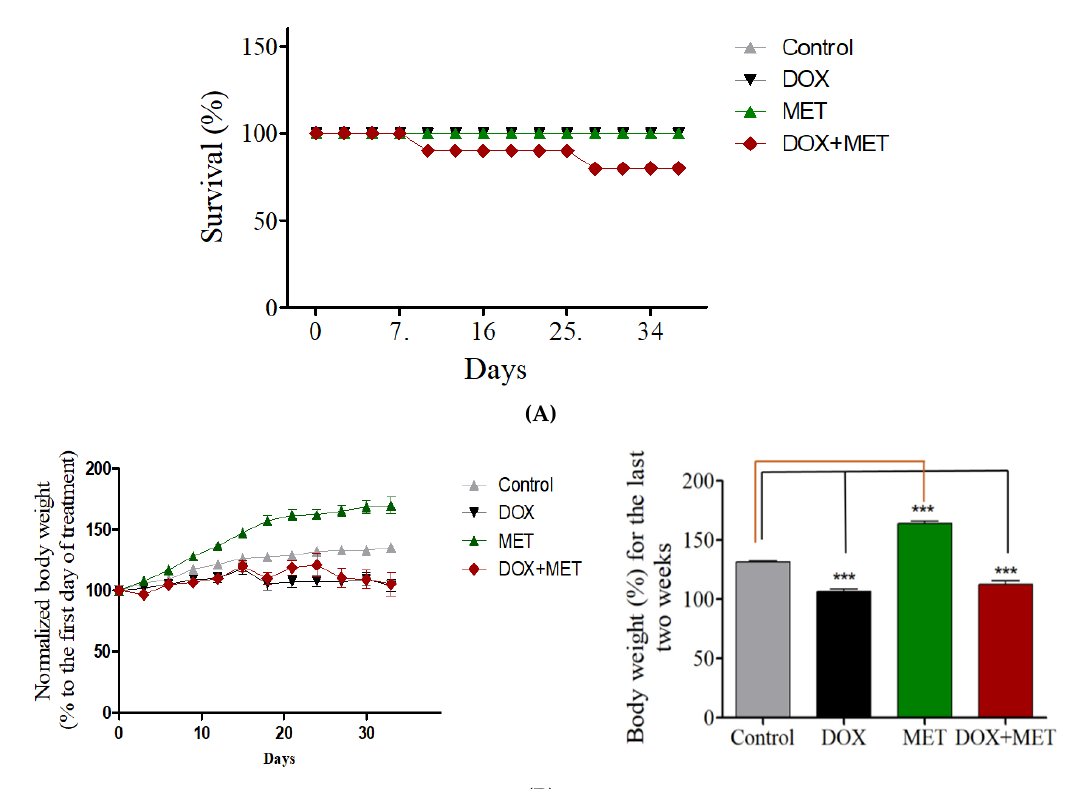
Figure 1. (A) Effects of doxorubicin (DOX) and metformin (MET) on survival rate of rats. (B) Effects Figure 1. ( A ) E ff ects of doxorubicin (DOX) and metformin (MET) on survival rate of rats. ( B ) E ff ects of of DOX and MET on rat body weight. DOX and MET on rat body